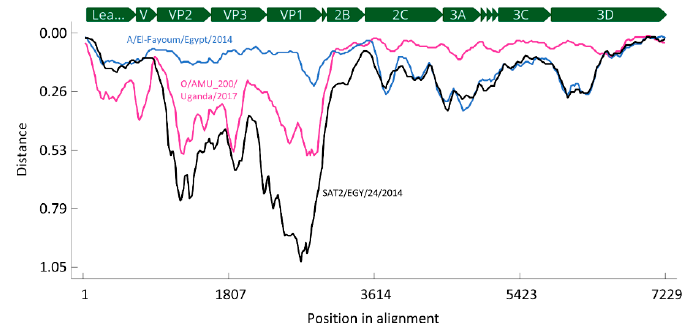
Figure 3. Distance plot of the serotype A virus from sample 10 against A/El-Fayoum/Egypt/2014 (blue), O/AMU_200/Uganda/2017 (purple) and SAT2/EGY/24/2014 (black). These observations point towards frequent recombination between FMD viruses of different serotypes cocirculating in endemic regions in Africa. It is important to remember that recombination requires that an animal (indeed the same cell) must be infected with two strains of FMDV at the same time. It is presently unclear whether recombination only occurs when two viruses cause an acute infection at the same time or if the superinfection of a persistently FMDV-infected carrier animal with a different virus strain will lead to the same outcome [6]. Due to the scarcity of publicly available full-genome sequence data of African FMDV isolates, it is impossible to determine when and where this recombination has occurred. It would certainly be a misinterpretation of the data to suggest that the virus from sample 10 (isolated from a river buffalo in Damietta Governorate, Egypt in 2016) and O/AMU_200/Uganda/2017 were immediately involved in this event. To the contrary, the considerable genetic distance between sample 10 and its closest relatives in the database (Table 2) indicates that there is a large gap in the publicly available sequence data and that we are missing information on many intermediate viruses. There have been no reports yet of O/EA-4 viruses like O/AMU_200 circulating in Egypt, but it is worth pointing out that closely related viruses of this lineage have been found in Ethiopia (Figure 4). Recombination between FMDV field strains of different serotypes has been documented previously [6,37–39], but this is the first report of an intertypic recombinant from Egypt. As has been pointed out by other authors, it is very important to recognize these events to avoid biases in phylogenetic analyses and vaccine selection [34,38,40]. The VP1-coding region only comprises of 8% of the FMDV genome and if analyses are restricted to this region, a large proportion of the genetic information is not accounted for [34]. 3.3. FTA Card Storage Experiment In the FTA card storage experiment, the original vaccine preparation had a mean FMDV C q value of 15. When the paper was processed 2 h after the vaccine had been applied to the card, about 15% of the RNA could be recovered (mean C q value 19.7). After 4 weeks, only about 2% of the original FMDV RNA was recovered from the card and this did not further decrease during another month (mean C q value 22.6 and 22.4, respectively). By six months after application of the vaccine to the FTA card, recovery had decreased to 1% (mean C q value 23.8). 3.4. Composition Analysis of 2019 Inactivated FMDV Vaccine The Egyptian vaccines spotted on the FTA cards had C q values in the FMDV real-time RT-PCR of 34.6 and 28.3. Assuming that the decrease in recoverable FMDV RNA was the same between the FTA cards prepared in Egypt and the storage experiment in the laboratory, the estimated C q values of the original vaccine preparations were 27 and 21, a considerably lower FMDV RNA content than in the vaccine used by Forth et al. [8], which had a C q of 15. For a standard inactivated and purified